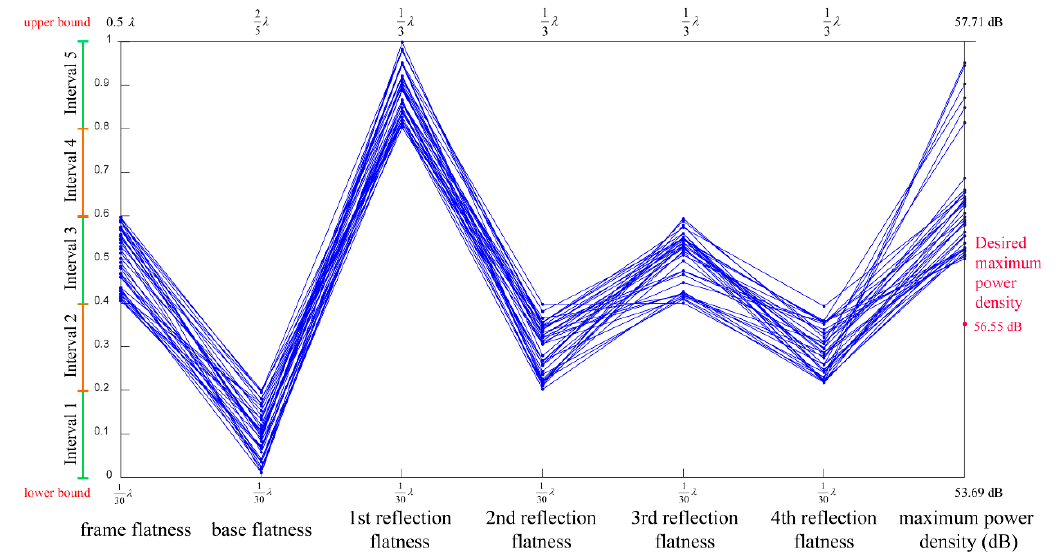
Figure 11. The parallel coordinates plot of all sets of samples passing the interval [3,1,5,2,3,2].